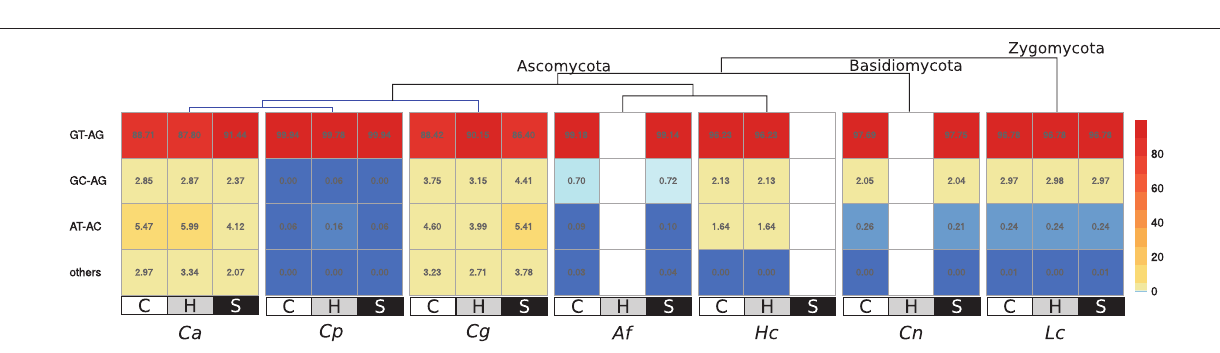
FIGURE 4 | Used splice sites in the studied species (in %) during control (C), response-to-host (H) and stress (S) conditions for each species are shown. “Others” summarizes the ratio of the splice sites CT-AC, CT-GC, GN-AG, and